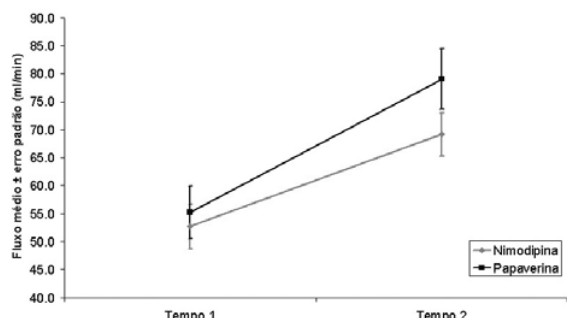
Fig. 1 - Gráfico de fluxos médios ± erros-padrão (ml/min) nos Tempos 1 e 2 para os fármacos nimodipina e papaverina, demonstrando semelhança dos fluxos nos diferentes tempos para os dois fármacos